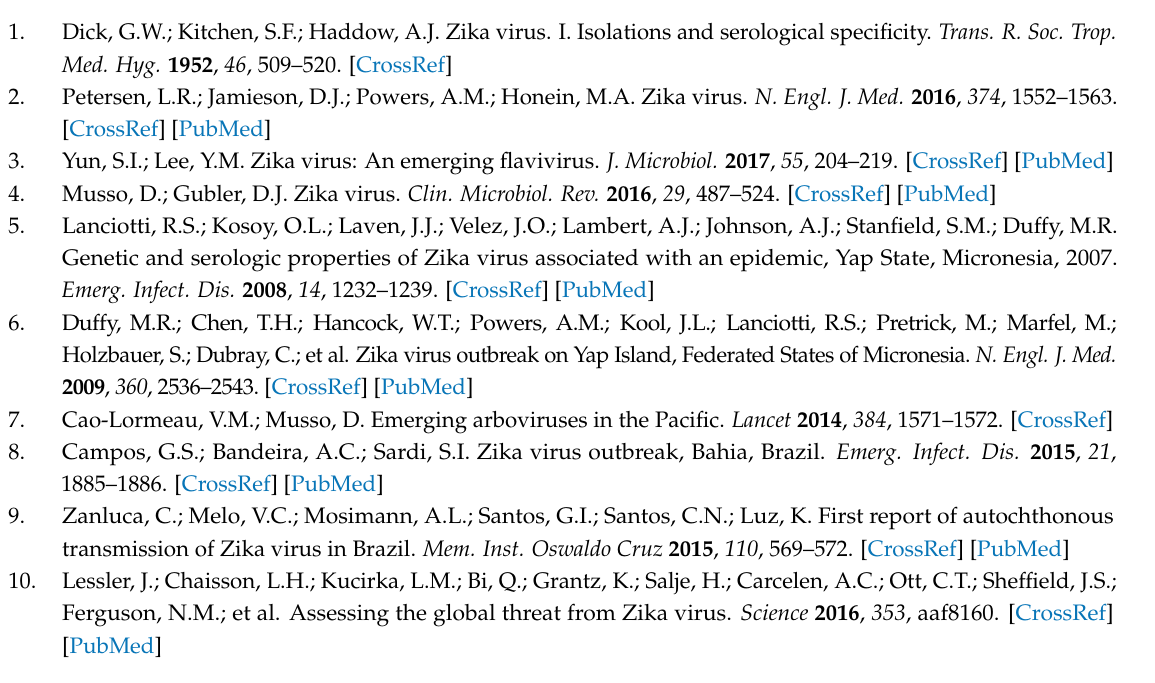
Figure S1: A single C 9804 → U substitution essentially eliminates the specific infectivity of RNA transcripts derived from a full-length infectious cDNA clone of ZIKV P6-740, Figure S2: Three functional ZIKV cDNA clones are stably propagated in bacteria as BACs, Figure S3: ZIKV growth kinetics and cytopathogenicity in cell cultures depend on the particular combination of virus strain and host cells, Figure S4: MDBK cells are highly susceptible to infection with both BVDV and VSV, Figure S5: Details of the 15 JEV region-specific rabbit antisera used to detect their antigenically cross-reactive ZIKV counterparts, Figure S6: Details of the seven ZIKV region-specific rabbit antisera used to identify ZIKV gene products and their related species, Figure S7: A missense mutation eliminating the N -glycosylation site at Asn-154 in the viral protein E of rP6-740 is responsible for the observed lower molecular weights of the E and its two related proteins, Figure S8: Multiple NS4A- and NS4B-related proteins are accumulated in ZIKV-infected